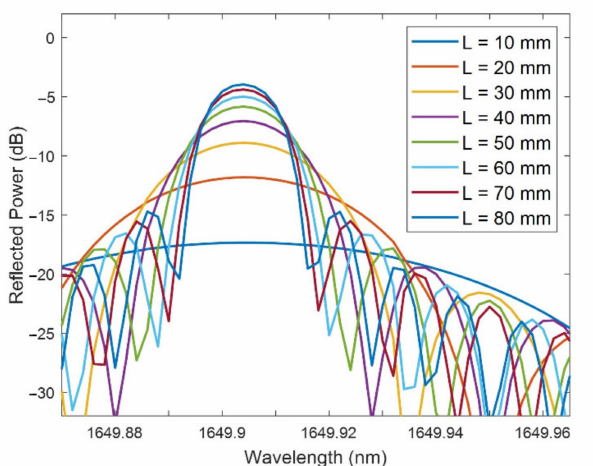
Figure 7. FBG bands for different values of the length of the D-shaped zone for a thin-film thickness of 25 nm and a neck of 0 µ m.